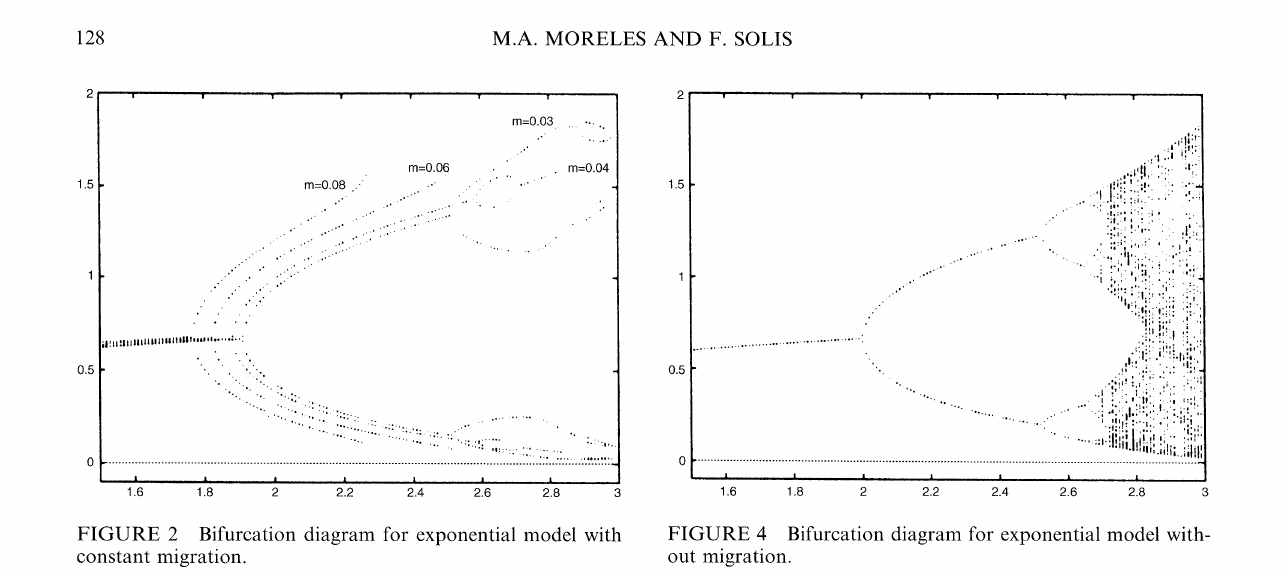
FIGURE 2 Bifurcation diagram for exponential model with constant migration.